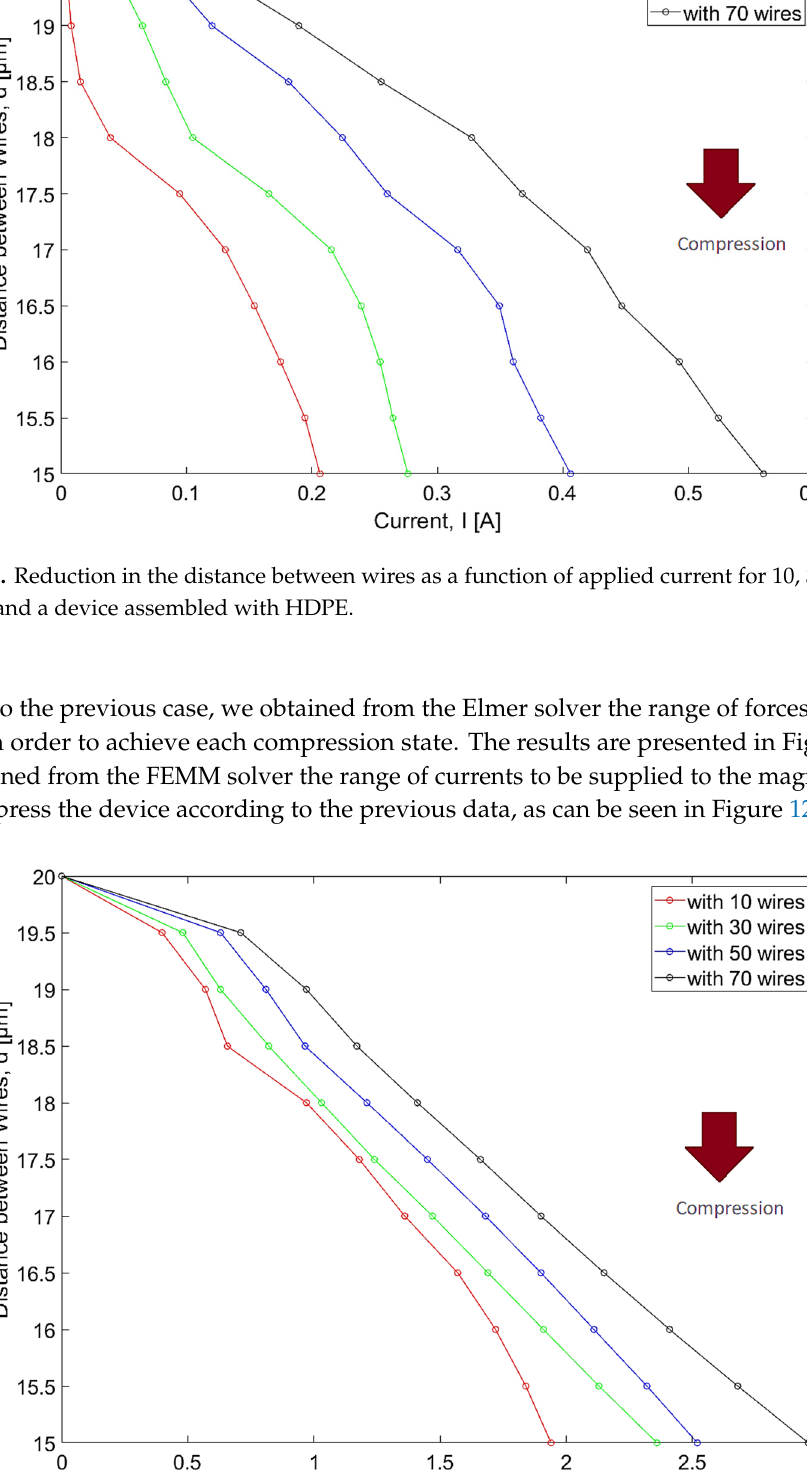
Figure 9. Reduction in the distance between wires as a function of applied force and current for 10, 30, 50 and 70 wires and a filter assembled with HDPE.